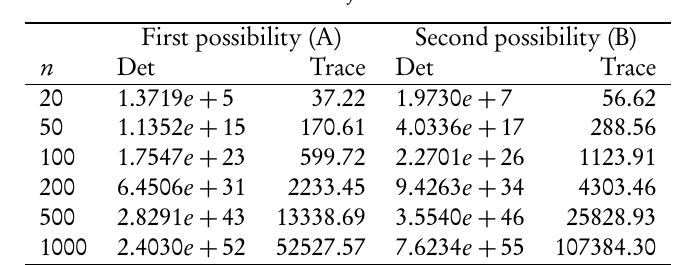
Predictive variances for the